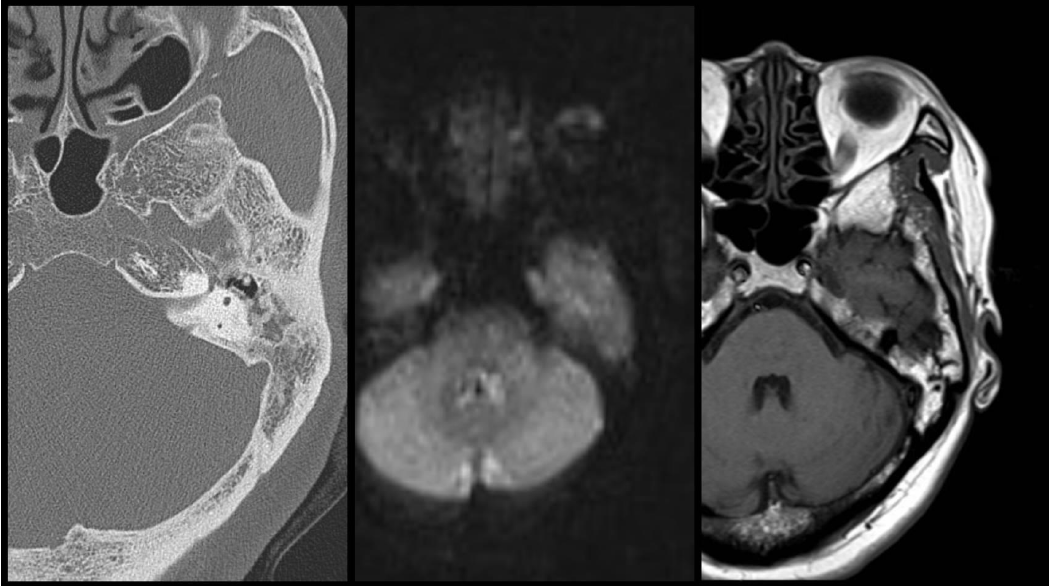
Figure 3. DW-T1W-CT images of false negative case (case 25). From left to right, CT-DWI-T1.